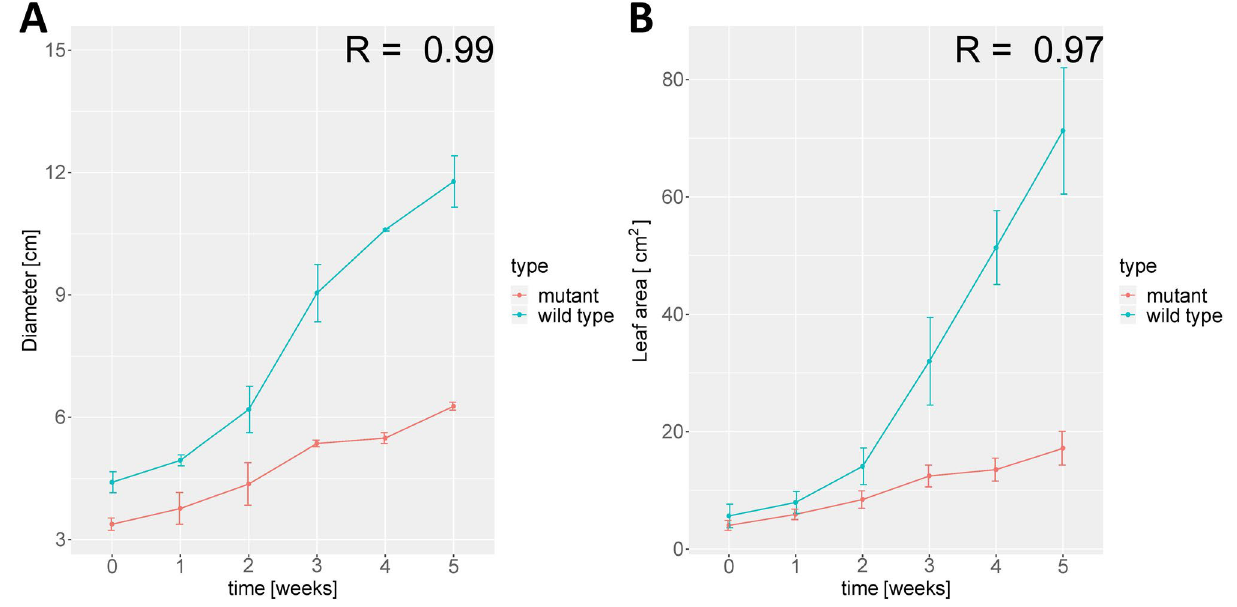
Figure 1. Morphometric analyses of reil1-1 reil2-1 and wild type after shift from optimized (20 ◦ C) to low temperatures (10 ◦ C). Reil1-1 reil2-1 double mutants and A. thaliana Col-0 wild type plants were shifted at developmental stage 1.10 29 . Week-0 plants were grown at 20 ◦ C and assayed before the temperature shift. Rosette diameter, ( A ); leaf area, ( B ), (mean +/− standard deviation; n = 3–10 plants), for original data and definitions of morphometric parameters refer to Schmidt et al. 2013 2 . The R coefficients represent the Pearson correlation between mutant and wild type with respect to the Diameter ( A ) ( P -value = 2.91 − 5 = 1.53 − ).